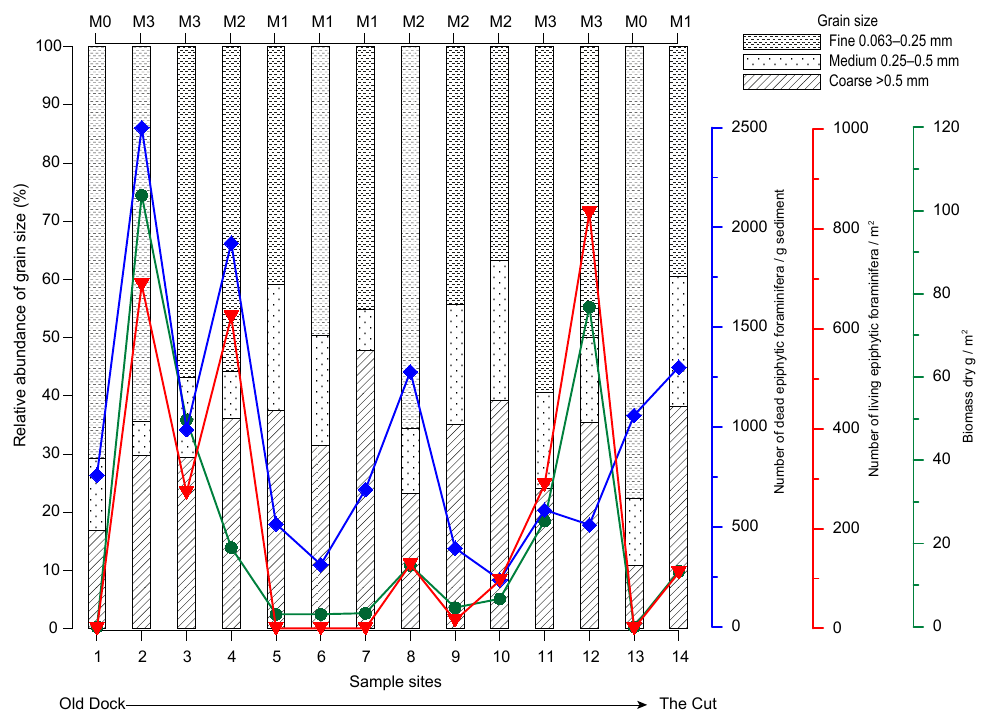
Figure 4. Graph showing physical and biological proxies (grain size, macrophyte biomass, and the number of living and dead epiphytic foraminifera) recorded at each sample site. The cumulative relative percentage of the grain size fractions is shown as a bar chart (dashed column: grains less than 0.25mm in diameter; dotted column: grain sizes between 0.25 and 0.5mm; hatched column: grains larger than 0.5mm). Macrophyte biomass, indicated by the green curve (green circles), is given in grams of dry biomass per m 2 . The distribution of epiphytic foraminifera is plotted as the number of specimens in the dead assemblage per gram of dry surface sediment (blue curve, blue diamonds). The number of specimens in the living assemblage per m 2 of vegetated area is shown in the red curve (red triangles). The curves show a subjective interpolation between the sample sites. The microhabitat index M0 for areas with no vegetation; areas with sparse vegetation, mainly calcareous macroalgae (M1); habitats with moderate vegetation of Syringodium –algae complexes (M2); and dense seagrass beds dominated by Thalassia and Syringodium